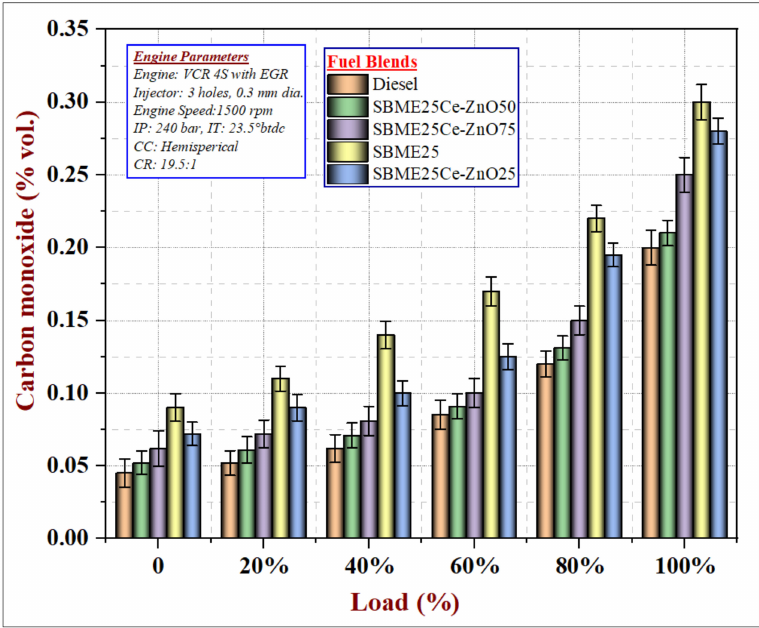
Figure 10. Variation of CO with load for di ff erent fuel